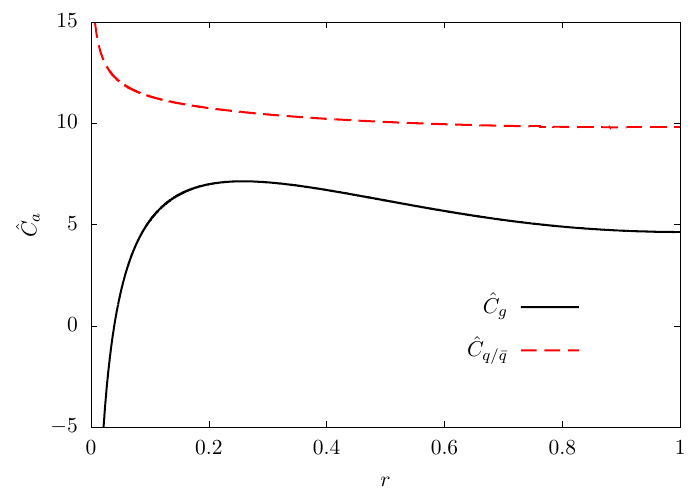
Figure 1 . The scale independent part ^ C a of the matching coe(cid:14)cient as a function of r = p T =m T for the two partonic channels as de(cid:12)ned in